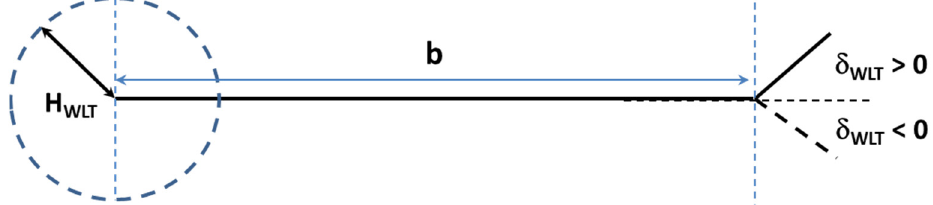
Figure 9. Definitions of the winglet parameters.